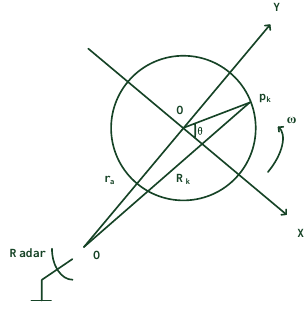
Figure 1 Geometry of the ISAR